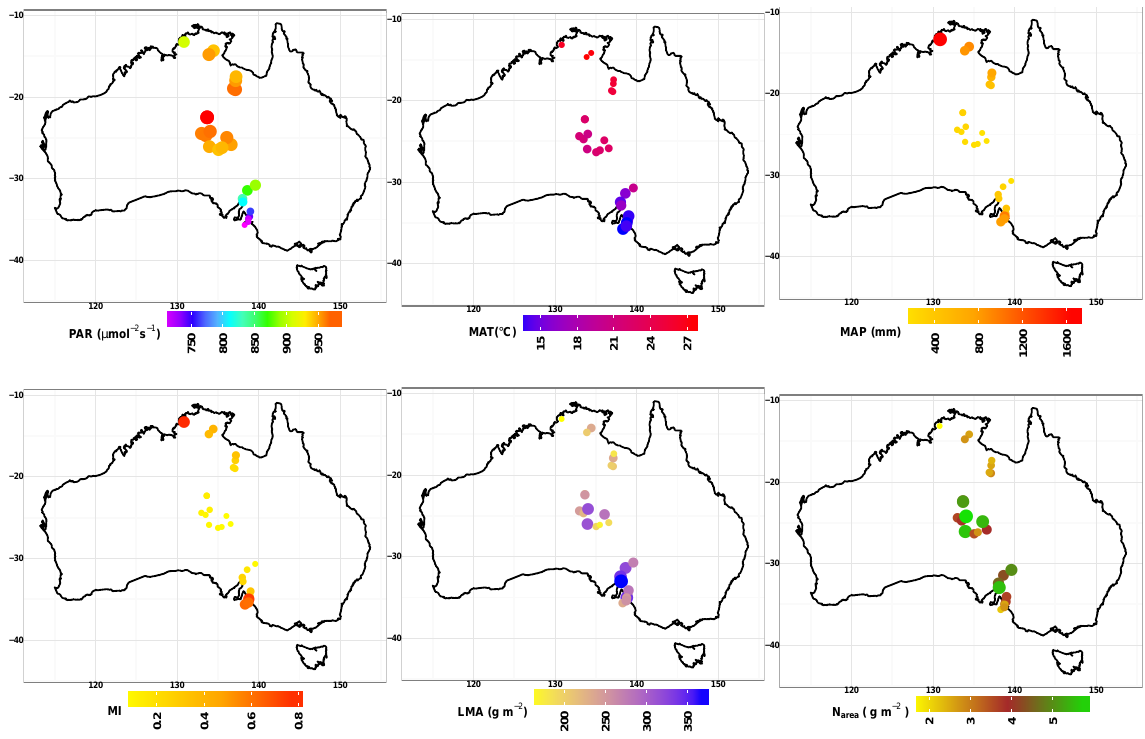
Figure 1. Site locations, climate, and leaf-trait distributions: mean annual precipitation (MAP, mm), mean annual temperature (MAT, ◦ ), mean incident daytime photosynthetically active radiation (PAR, µmol m − 2 s − 1 ) , moisture index (MI). Site mean N area (gm − 2 ) and LMA (gm − 2 ) are also